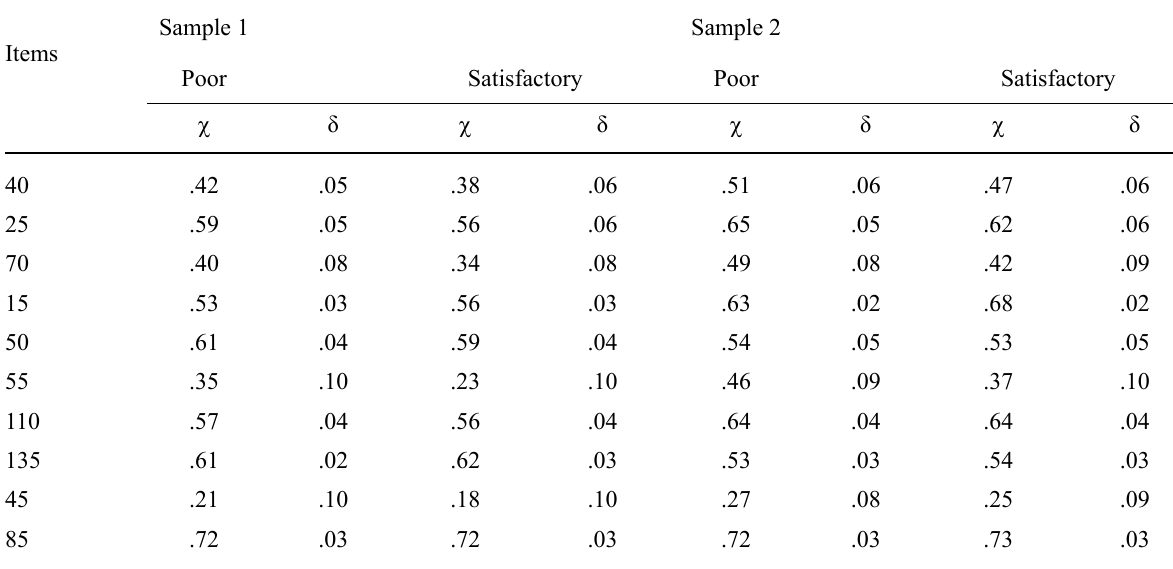
Table 5 Completely Standardized MLE Parameter Estimates for Poor and Satisfactory Fitting Single-Factor Models: